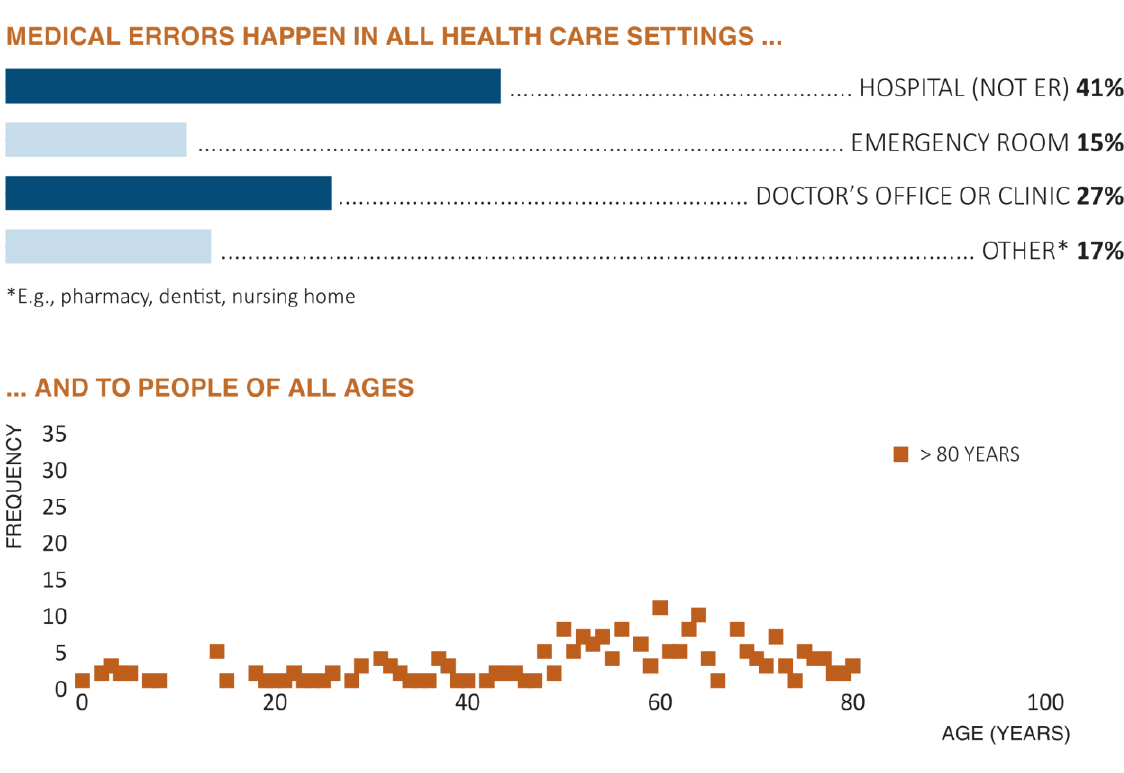
Figure 3. The top 10 of the most frequent errors [57].